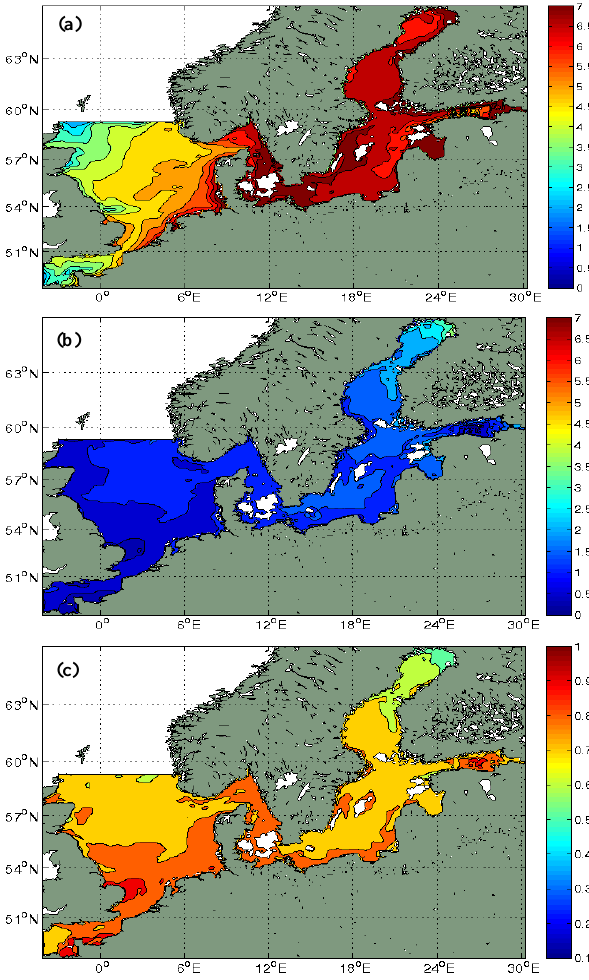
Figure 2, The standard deviation of SST in the North Sea and Baltic Sea (a) before and (b) after the Fig. 2. The standard deviation of SST in the North Sea and Baltic removal of the annual and semi-annual harmonics. The contour interval is 0.5 º C. (c) gives the Sea (a) before and (b) after the removal of the annual and semi- percentage of the total variances accounted by the annual and semi-annual harmonics, the contour annual harmonics. The contour interval is 0.5 ◦ C. (c) gives the per- interval is 0.1. centage of the total variances accounted by the annual and semi- annual harmonics, the contour interval is